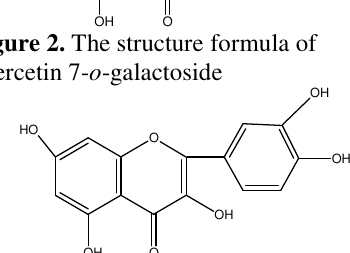
Figure 3. The structure formula of kempferol Figure 4. The structure formula of